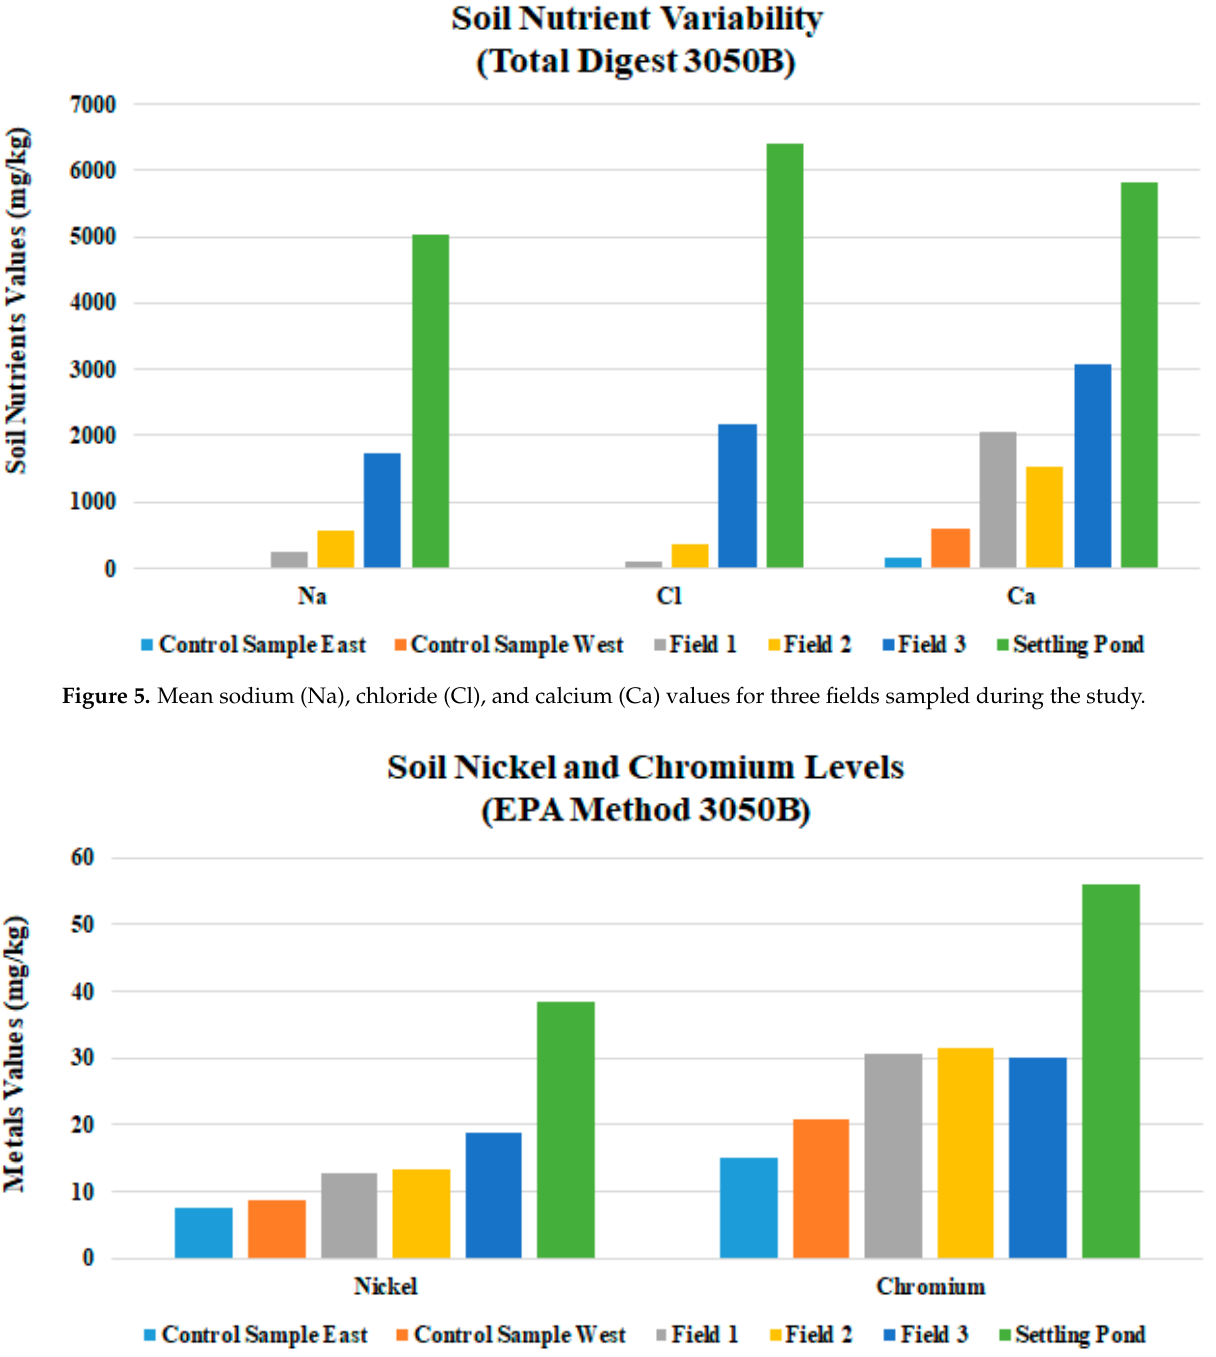
Figure 6. Mean values for nickel and chromium of Fields 1, 2, and 3 and Control Samples East and West. EPA: Environmental Protection Agency